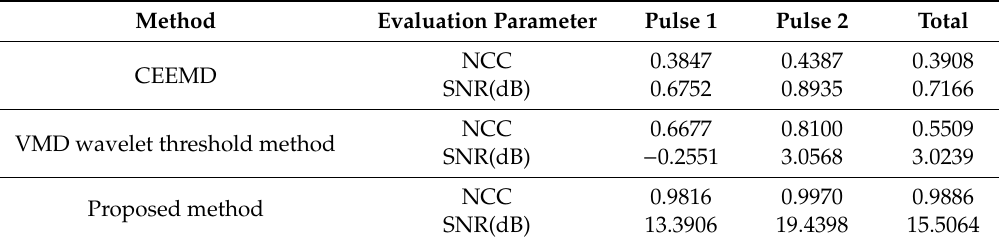
Table 4. Quantitative results of different methods.